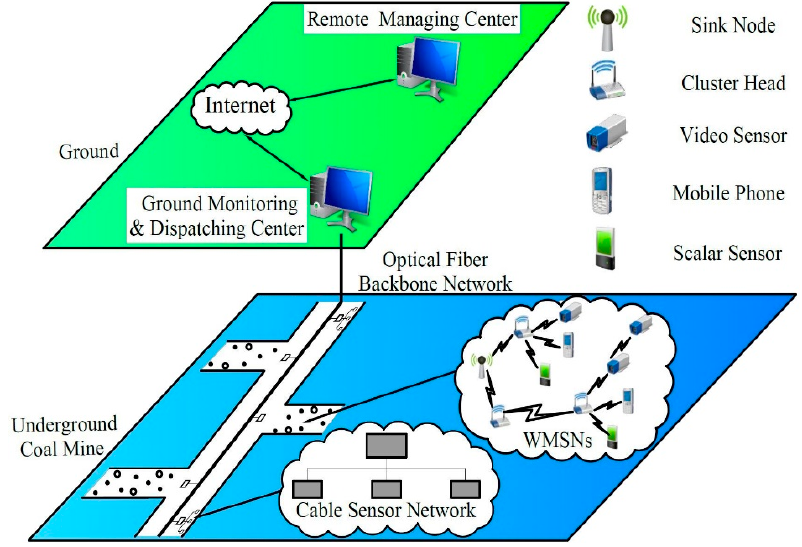
Figure 1. Network structure of the monitoring system for underground coalmines.